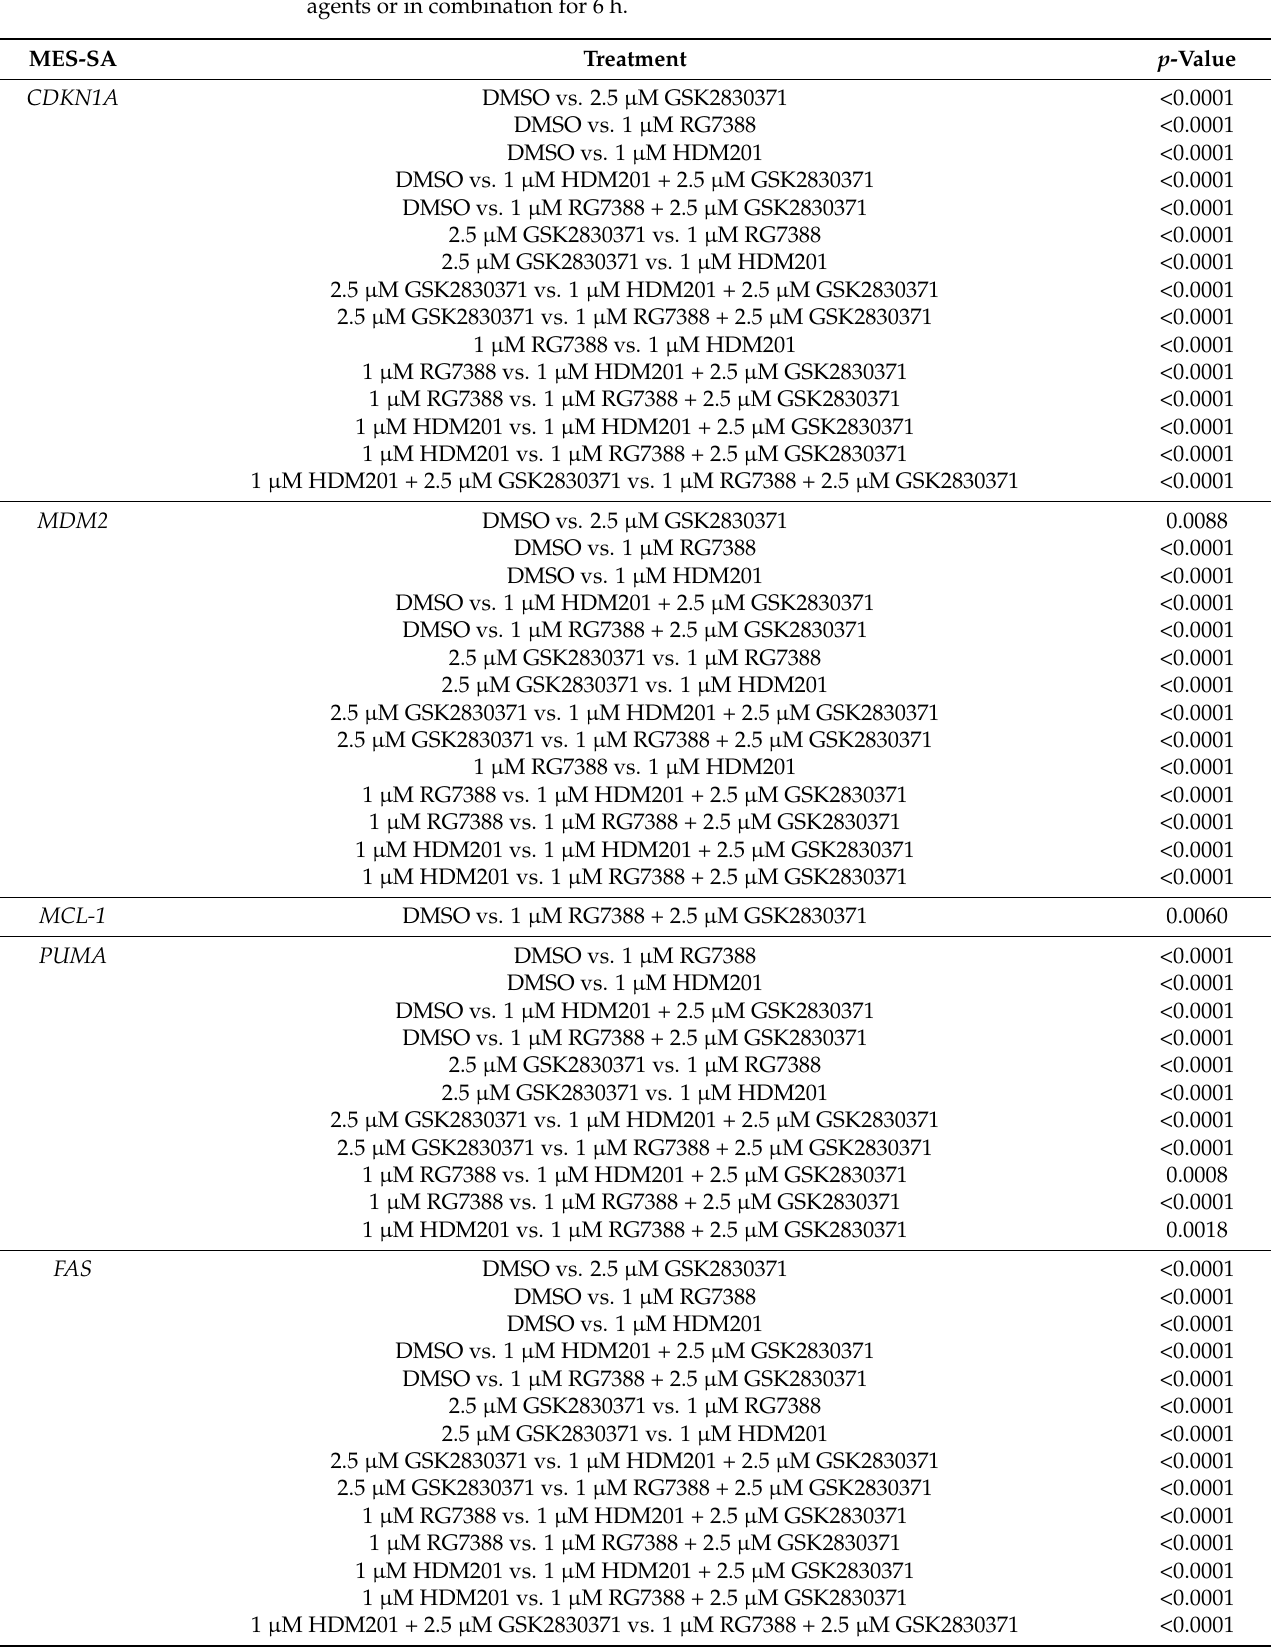
Table A3. All statistically significant fold changes in mRNA expression of selective p53 transcriptional targets, as determined by a two-way ANOVA with Tukey’s post hoc test for multiple comparisons between MES-SA cells when treated with RG7388/HDM201 inhibitors and GSK2830371 as single agents or in combination for 6